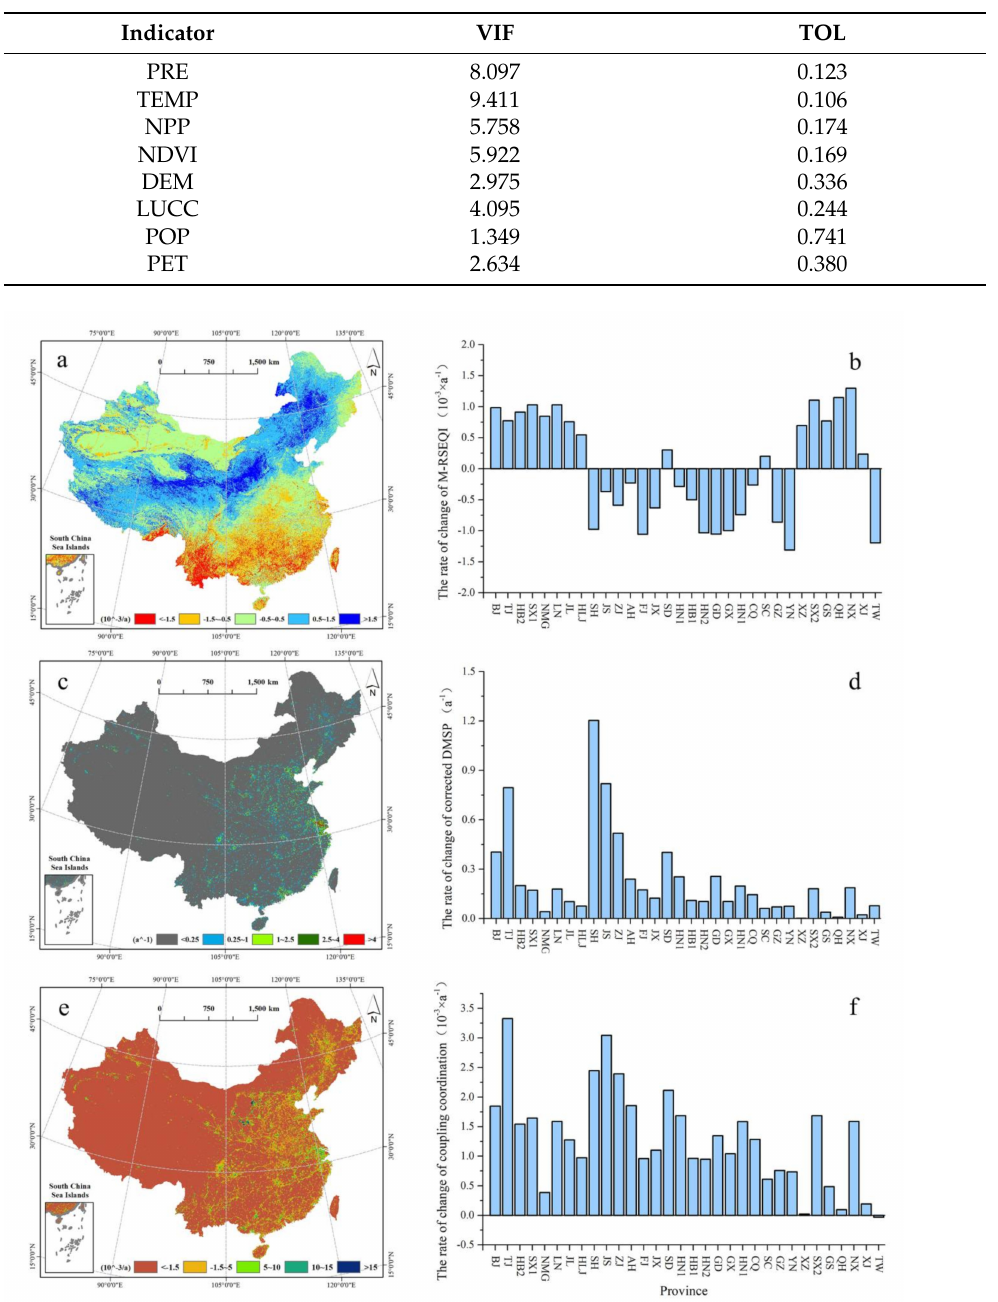
Table 3. Collinearity diagnosis results.